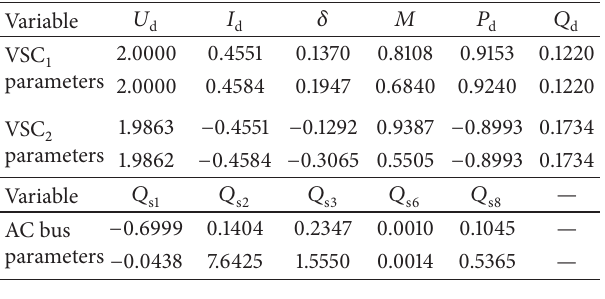
Table 3: Power flow data at initial and maximum load states for mode “1.”